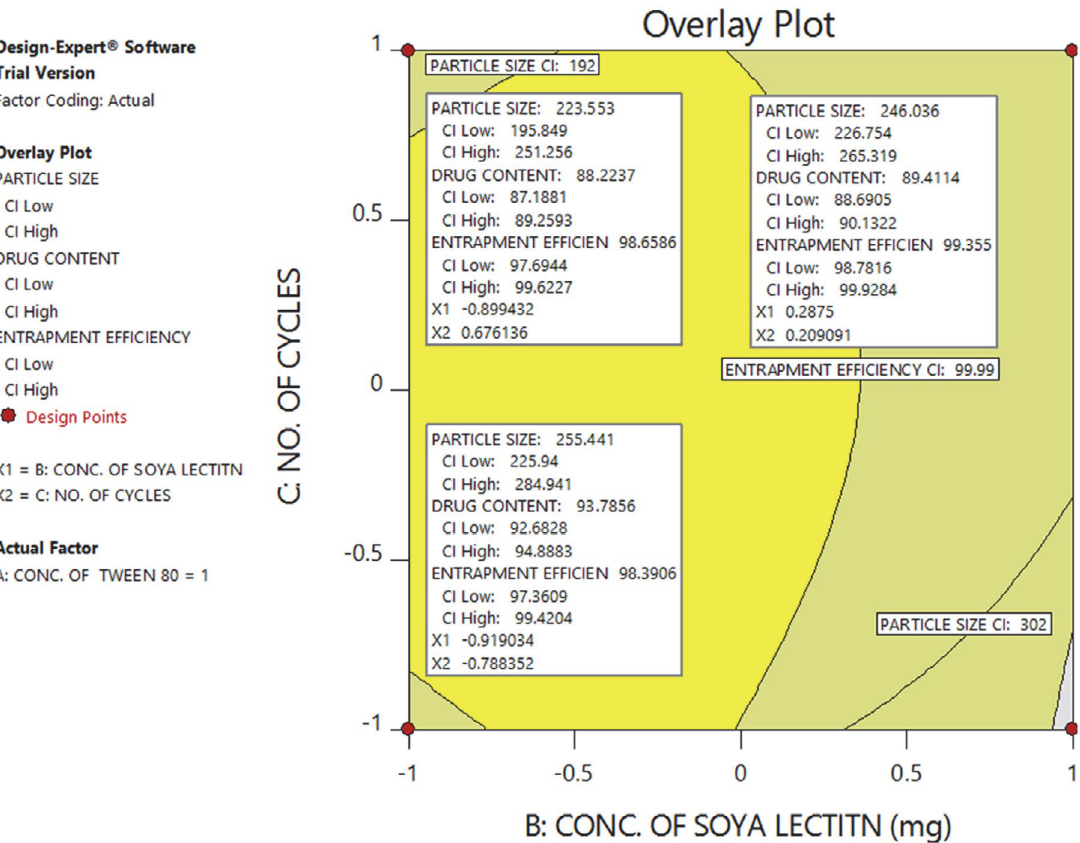
Figure 5. Overlay plot proposed by the design expert software showing design space in yellow colour along with the compositions of selected opti- mized formulations with the